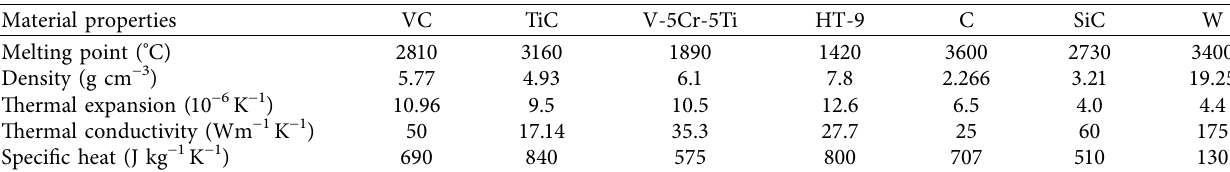
Table 2: Material candidate properties of the frst wall (FW)